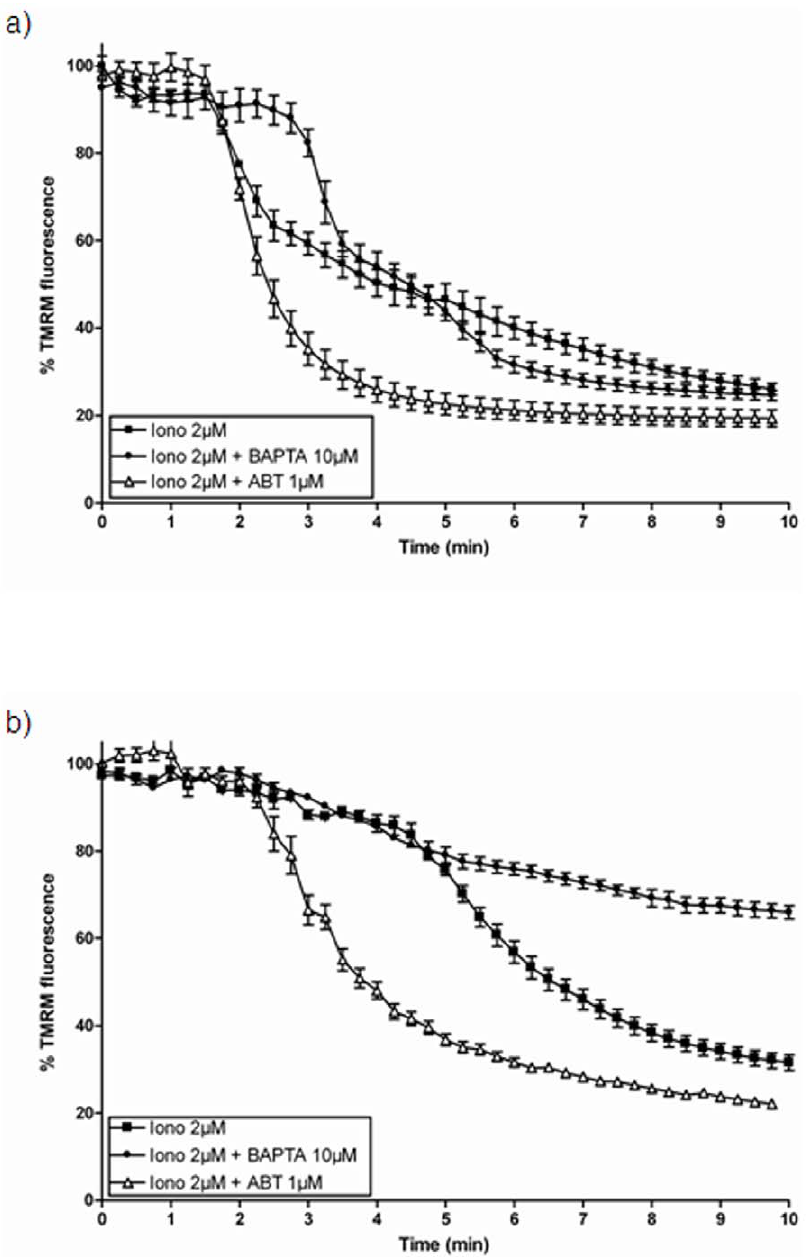
Figure 8. Effect of BAPTA-AM and ABT-737 on ionomycin-induced Dy m . The effect of BAPTA-AM and ABT-737 on ionomycin-induced Dy m was studied in both a) SH-SY5Y/Neo and b) SH-SY5Y/Bcl-x L cells treated with either vehicle, BAPTA-AM (10 m M) or ABT-737 (1 m M) for 30 minutes and then loaded with TMRM. Afterwards, cells were washed in Krebs solution and Ionomycin (2 m M; Iono) was added and Dy m was measured on-line as a decrease in TMRM fluorescence. Each data point represents mean 6 S.E.M. of 15 individual cells from 3 different